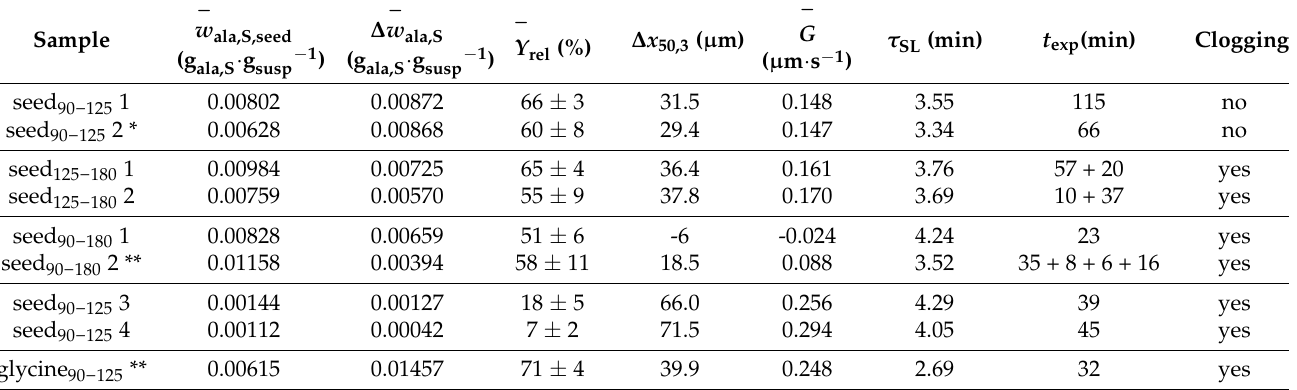
Table 3. Crystal growth results in 4